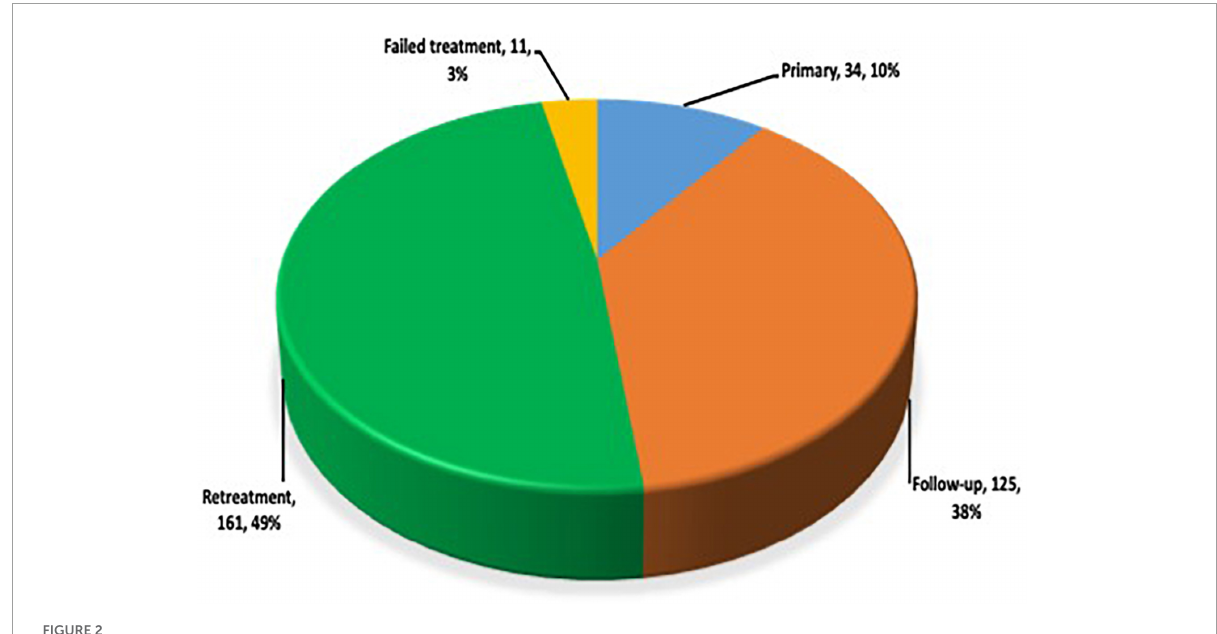
FIGURE2 Distribution of study participants by patient category.